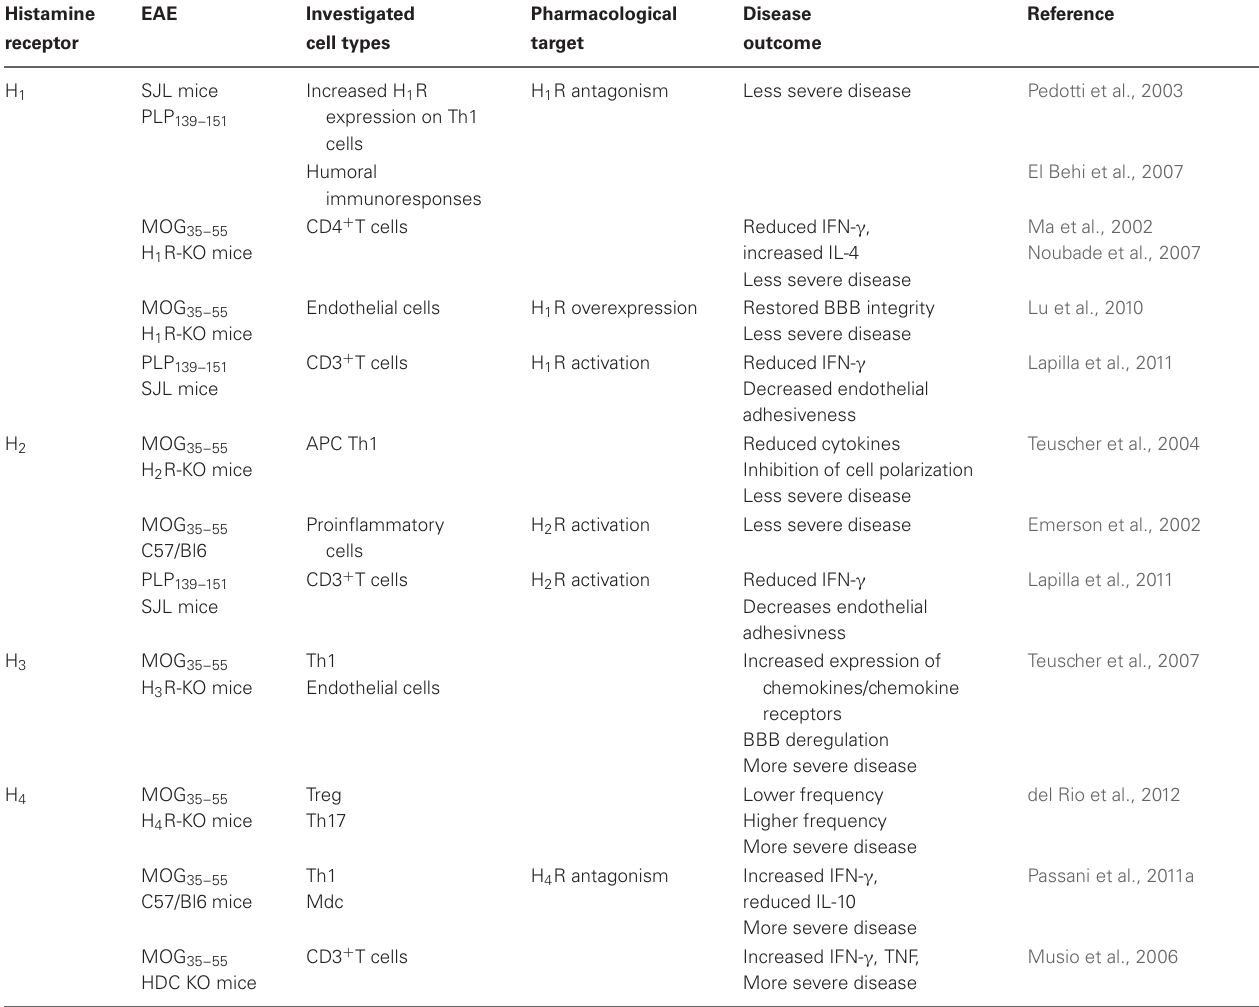
Table 1 | Histamine receptors and